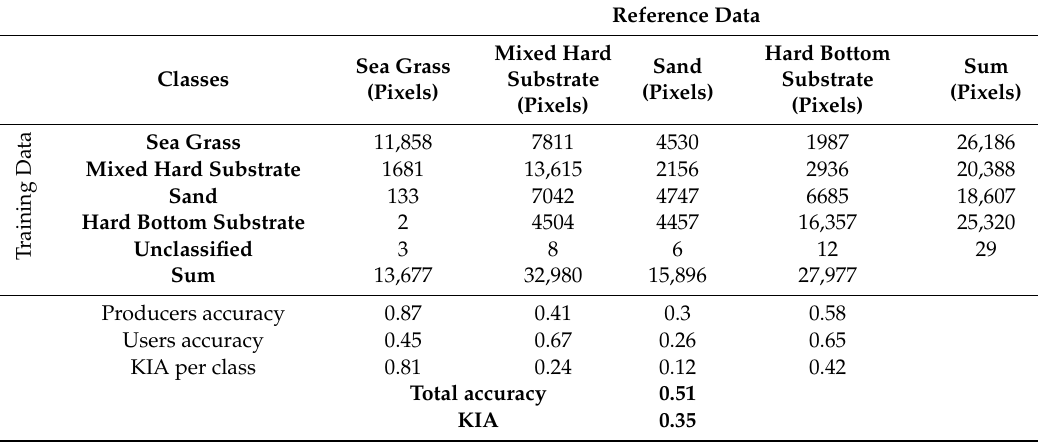
Table 9. Echo sounder data classification accuracy matrix for the multispectral